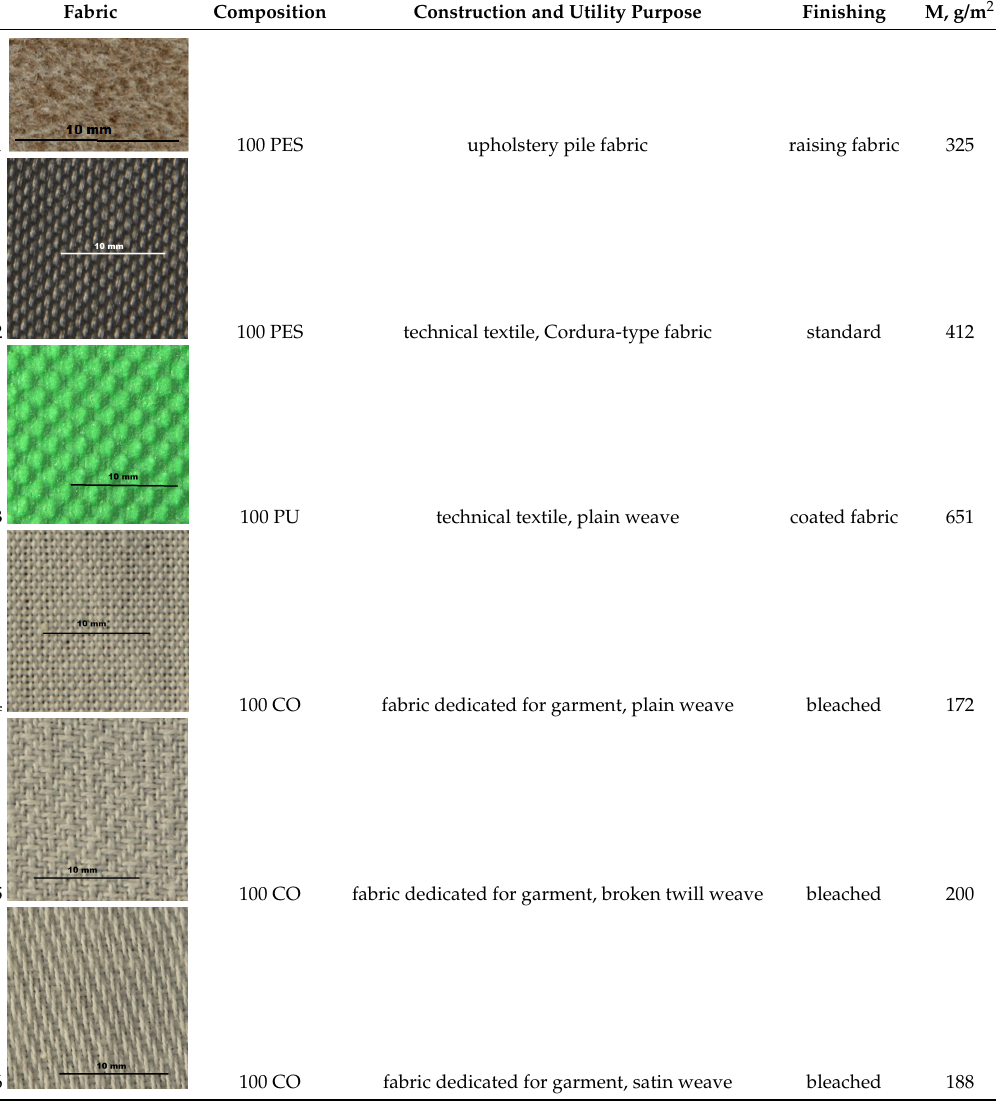
Table 1. The characteristic of fabrics.